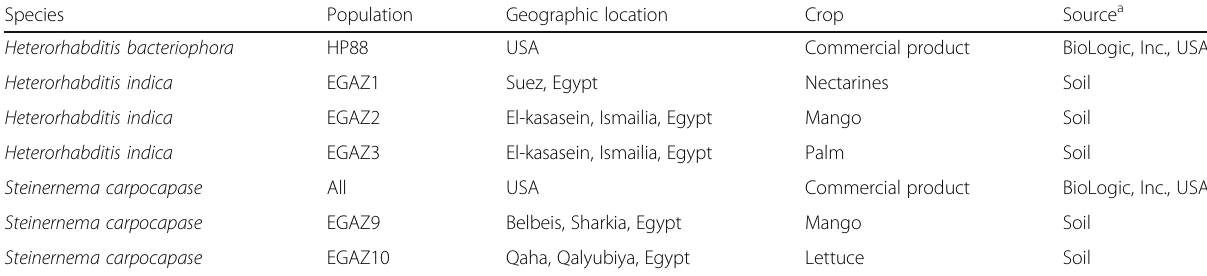
Table 1 Locality, crop, and source of entomopathogenic nematode populations used in the present study Species